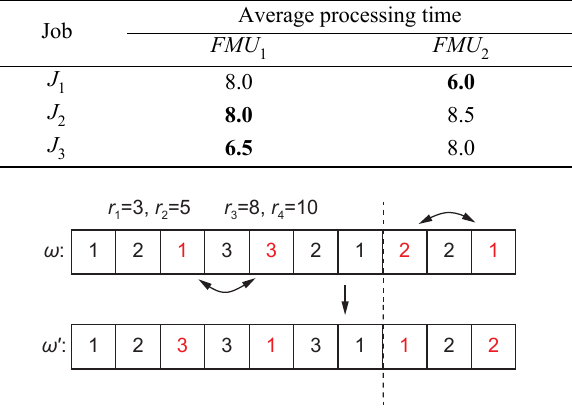
Fig. 4 On-wall ineffective collision